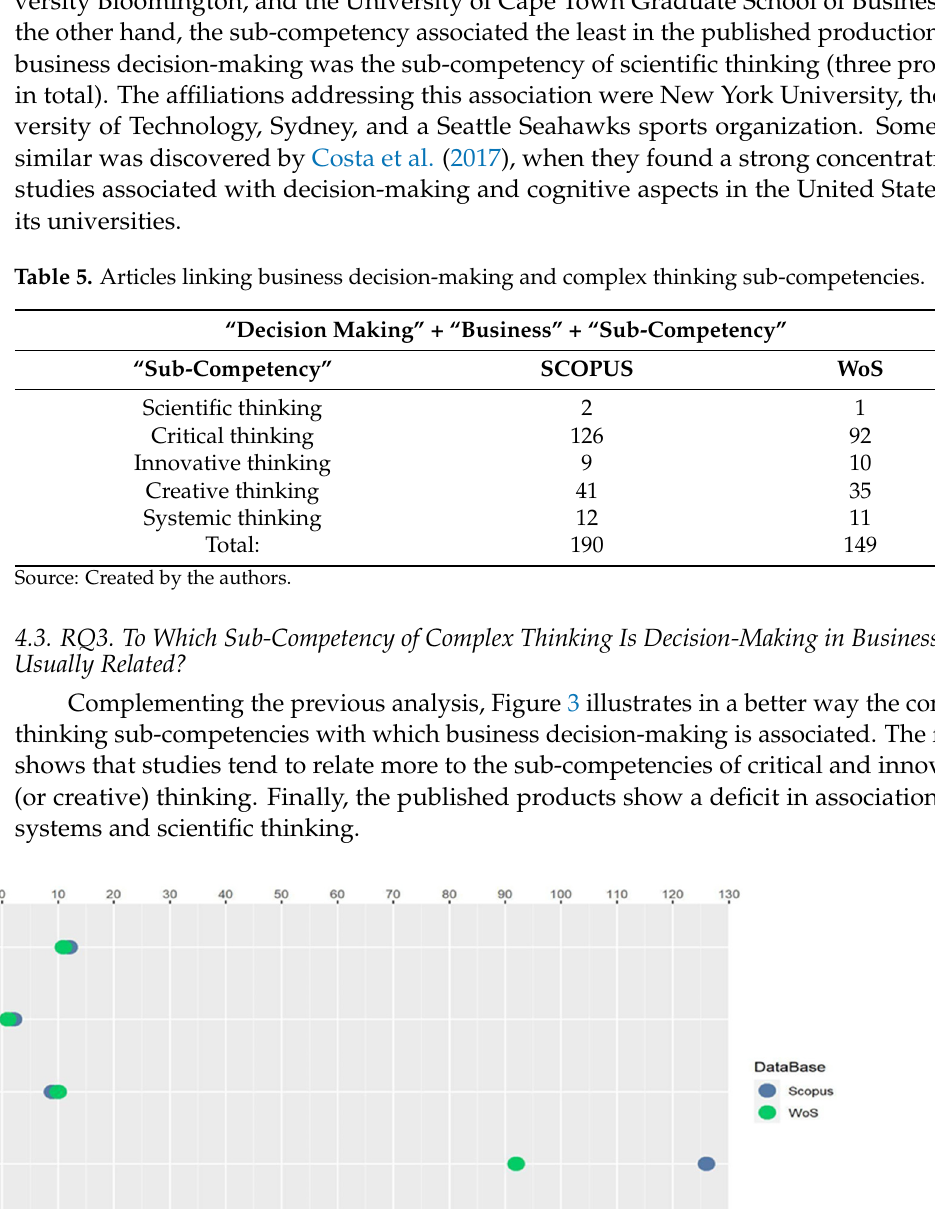
Figure 4. Annual Production. Source: Created by the authors. 4.5. RQ5. Which Institutions Have Produced the Most Products on Business Decision-Making Related to the Complex Thinking Competency and its Sub-Competencies? The institutions whose production links business decision-making with complex thinking or its sub-competencies are primarily located in the United States, with Georgetown University Medical Center producing the most academic publications with this thematic association. On the other hand, to a lesser extent, the University of Cape Town in South Africa or the University of Maribor in Slovenia had publications on these topics, but not as significant (Table 6).